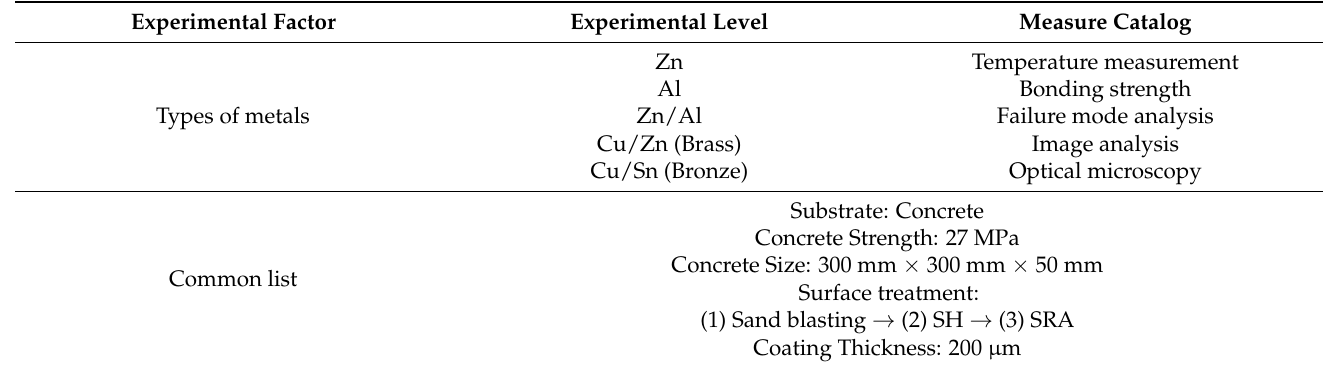
Table 1. Experimental factors and measuring